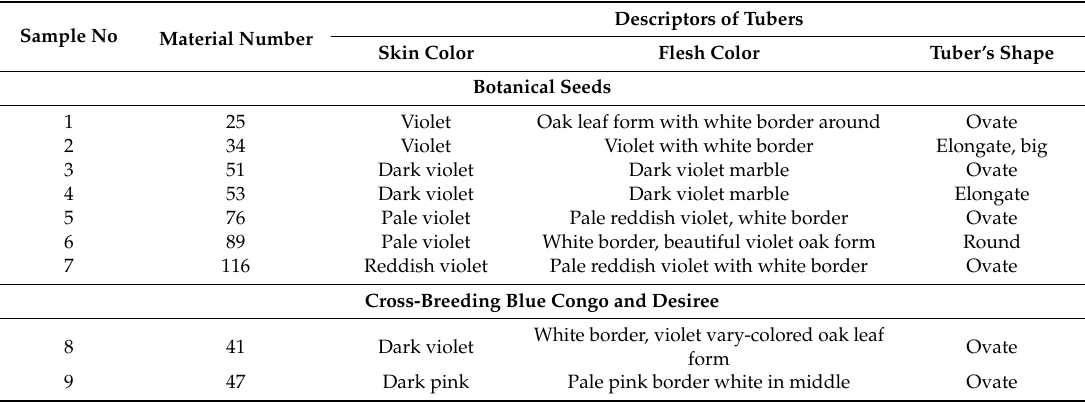
Table 1. Descriptors for tubers of the variety Blue Congo seedlings and cross-breeds between Blue Congo with Desiree and Blue Congo with